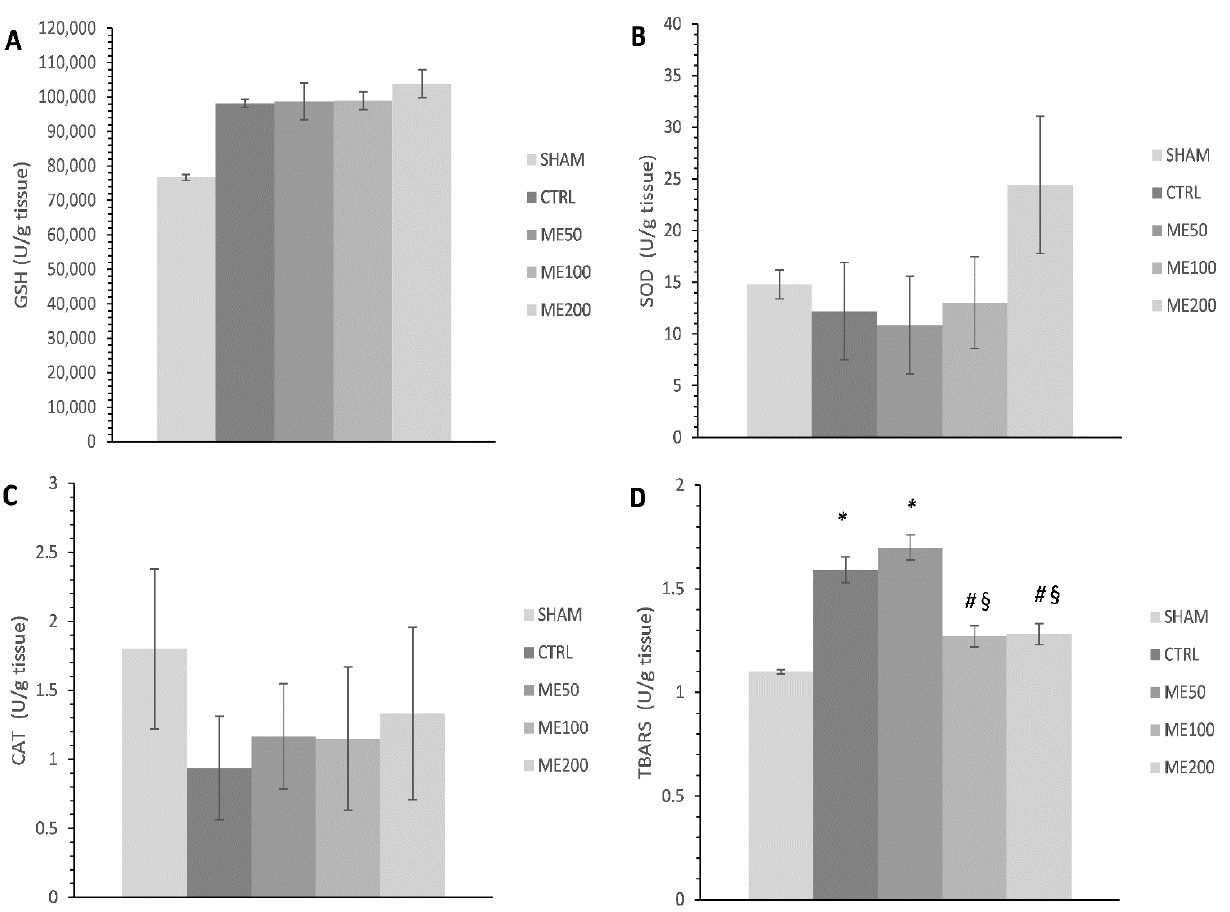
Figure 3. Effects of short-term heart preconditioning with ME on oxidative stress parameters in the heart tissue homogenate. ( A ) GSH—reduced glutathione; ( B ) SOD—superoxide dismutase; ( C ) CAT—catalase; ( D ) TBARS—index of lipid peroxidation measured as thiobarbituric acid